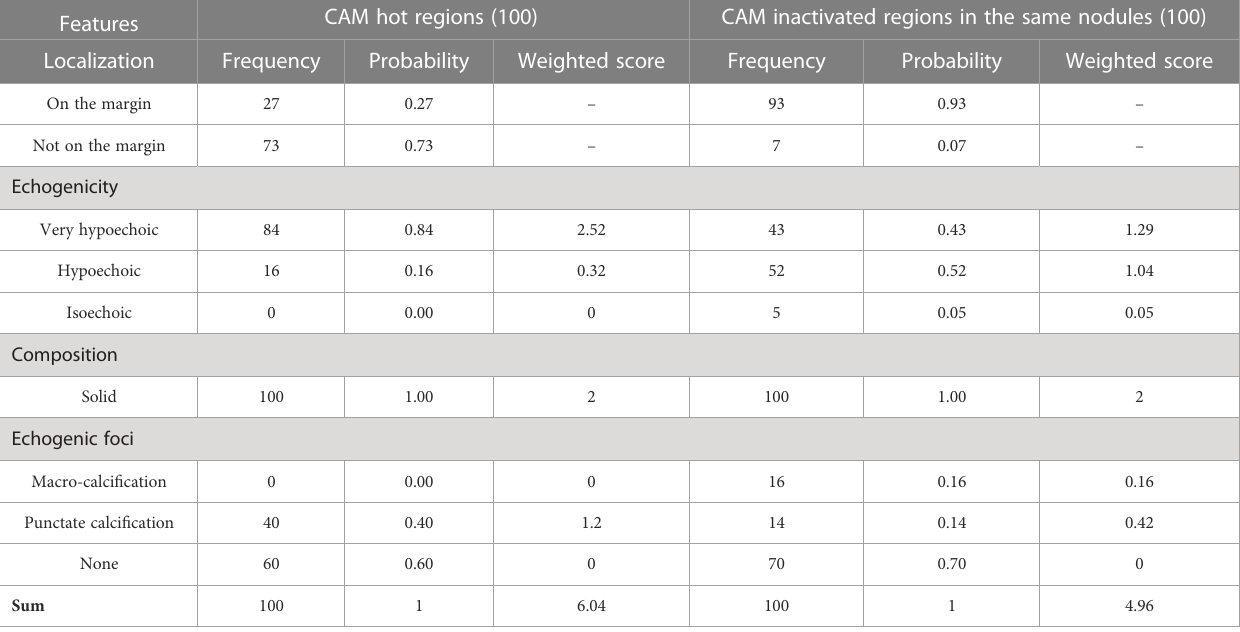
TABLE 2 The ACR TI-RADS feature analysis of CAM highlighted and inactivated regions in 100 malignant nodules randomly selected from the dataset.